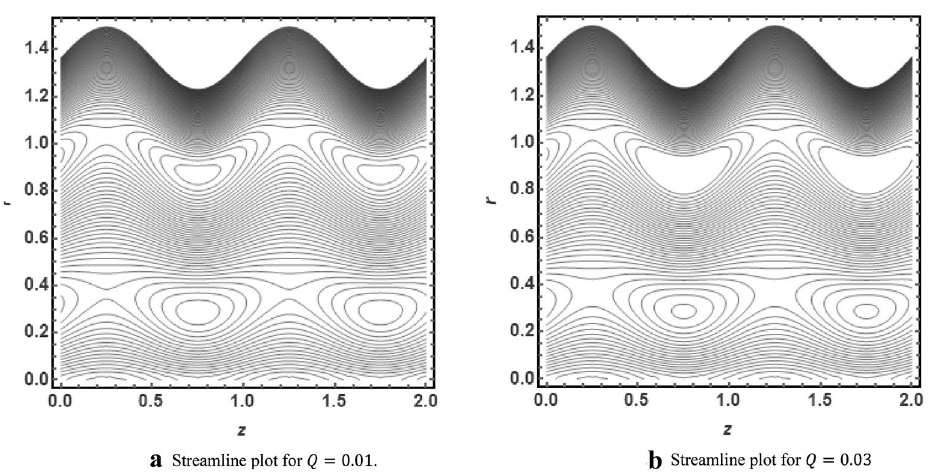
Figure 8. ( a ) Streamline plot for Q = 0.01 . ( b ) Streamline plot for Q = 0.03